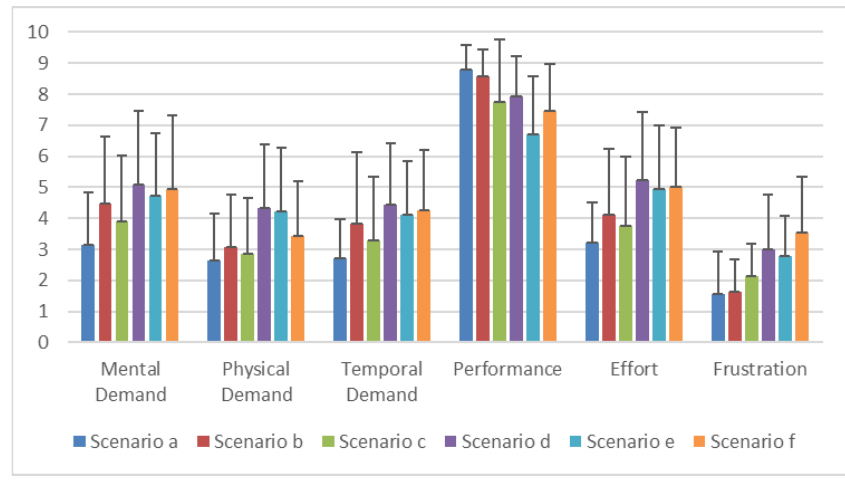
Figure 6. Average and standard deviation of TLX results per scenario and category.